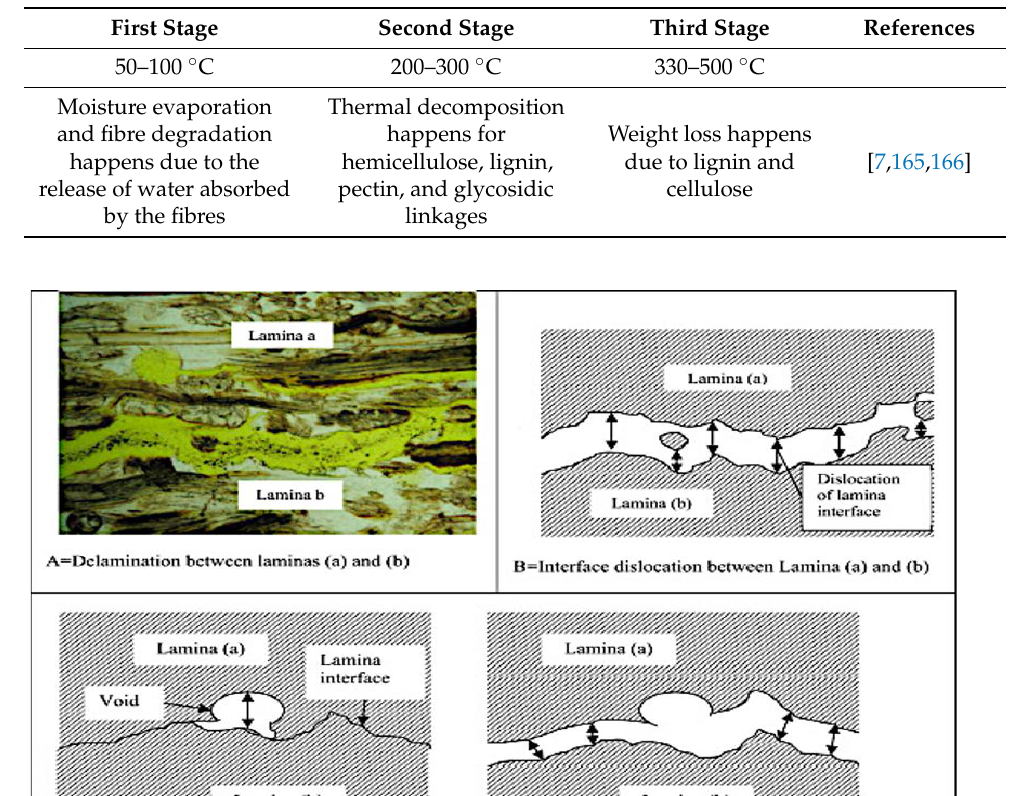
Table 5. Different stages of thermal degradation of natural fibres.